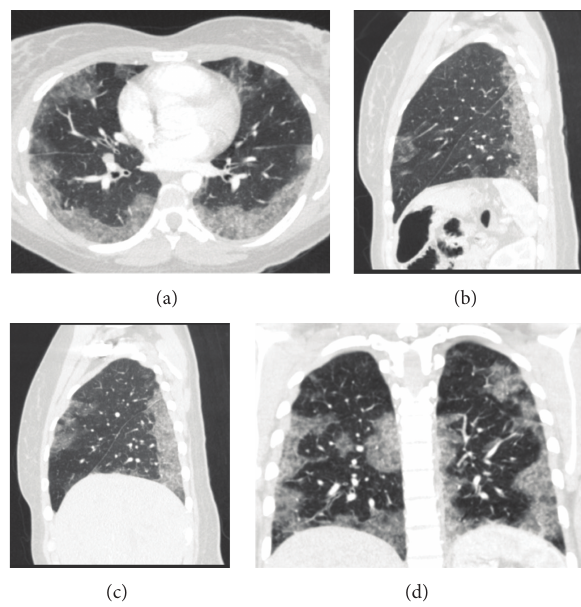
Figure 2: A 30-year-old female after illicit silicone injection. Findings: CT pulmonary angiography (axial (a), left sagittal (b), right sagittal (c) and coronal (d)) demonstrates diffuse, bilateral, ground-glass opacities greater on the right than on the left and predominantly at the lung bases.